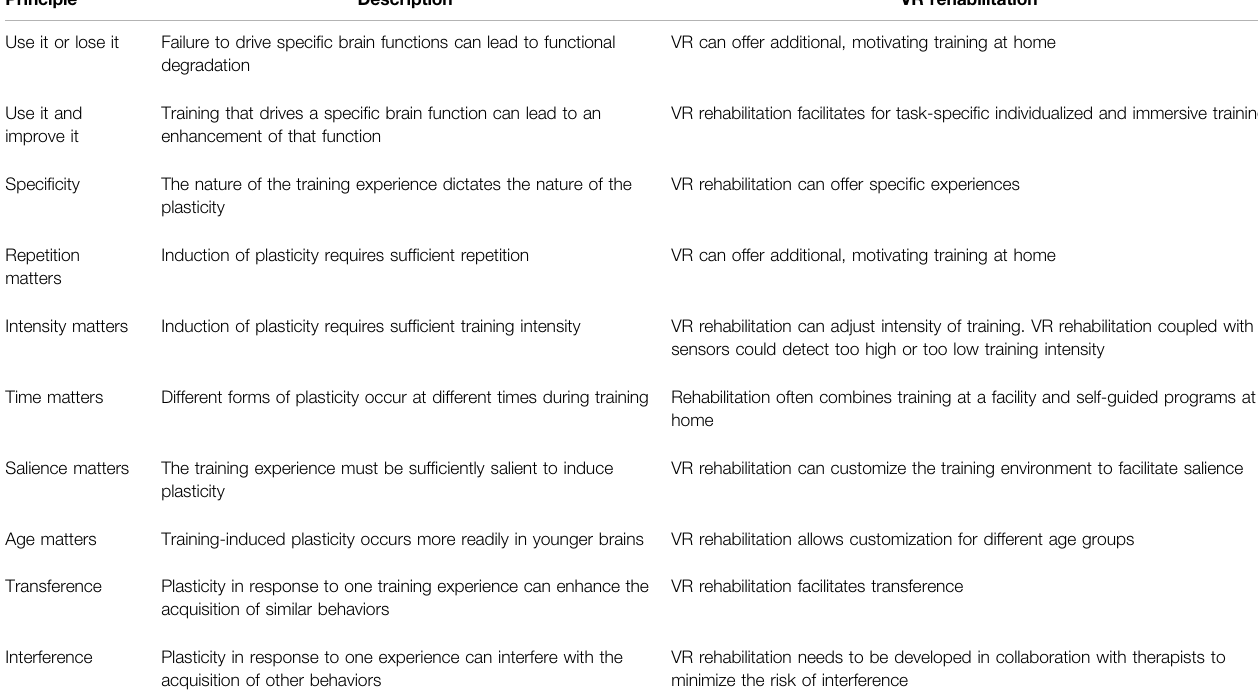
TABLE 2 | Based on Kleim and Jones (2008): Principles of experience-dependent plasticity further developed to include VR possibilities.